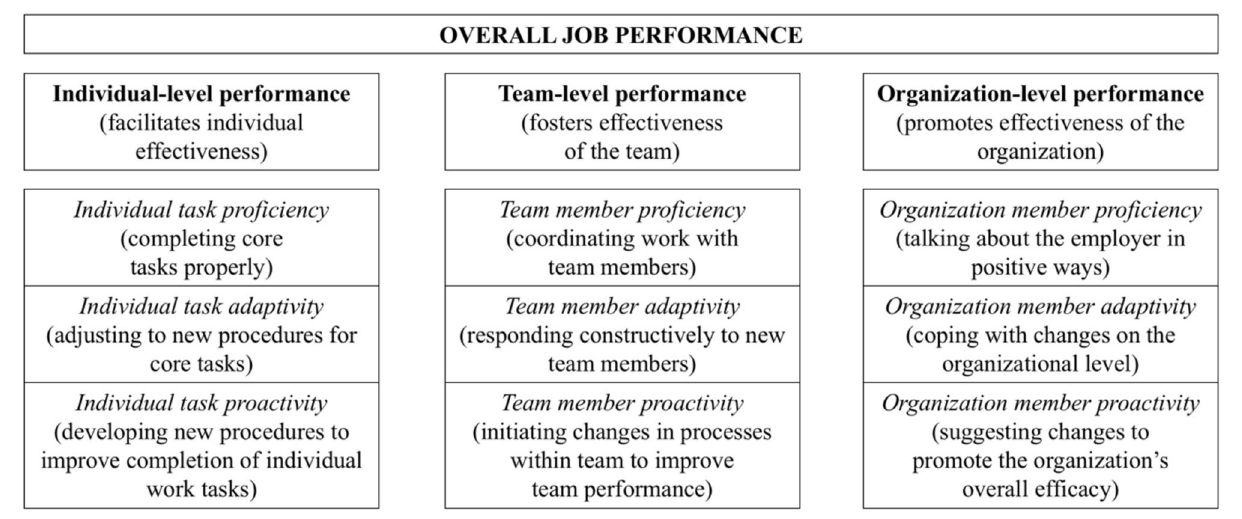
FIGURE 1 | Components and brief definitions of Griffin’s (2007) model of job